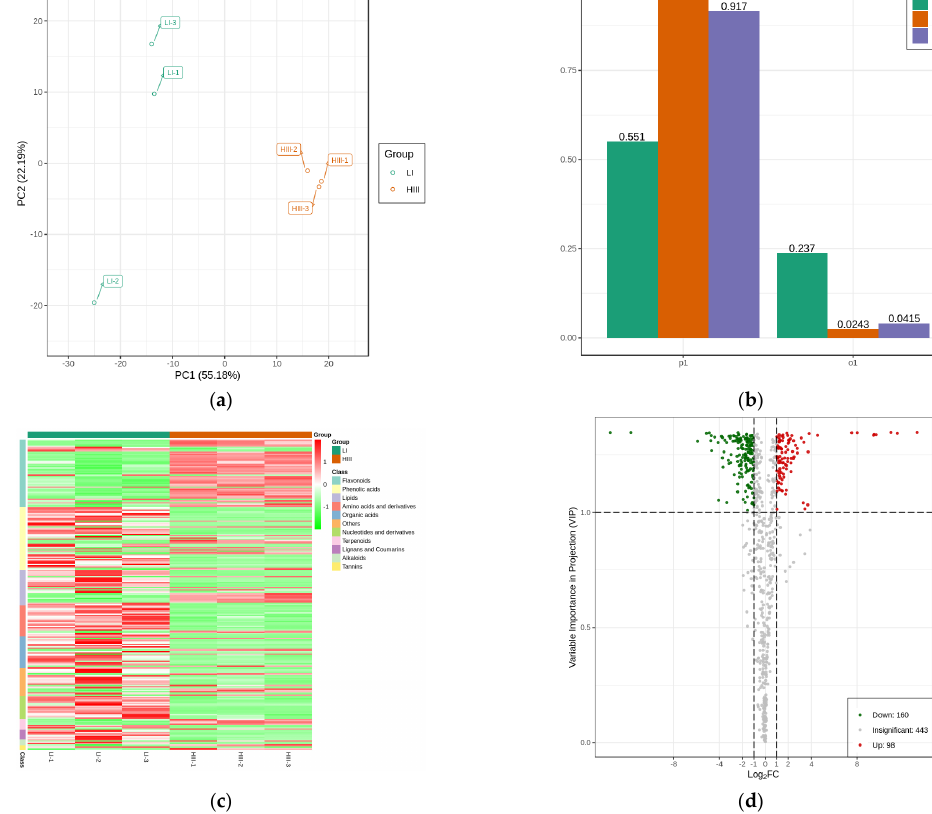
Figure 3. Results of a multivariate statistical analysis of metabolites from Zhongzhe 1 sugarcane, which exhibits high resistance to smut disease (HIII), and G160 sugarcane, which exhibits low resistance to smut disease (LI). ( a ) PCA score plot of metabolites in young shoots of HIII plants (red) and LI (green) plants; the x ‐ axis represents the first PC, and the y ‐ axis represents the second PC. ( b ) PLS ‐ DA score plot of metabolites between the young shoots of HIII (red) plants and LI (green) plants. ( c ) The 701 metabolites identified were divided into 11 categories. ( d ) Volcano plots of metabolites between the young shoots of HIII plants and LI plants. Metabolites with q values > 0.05 are highlighted in red when they increased in abundance and in green when they decreased in abundance.